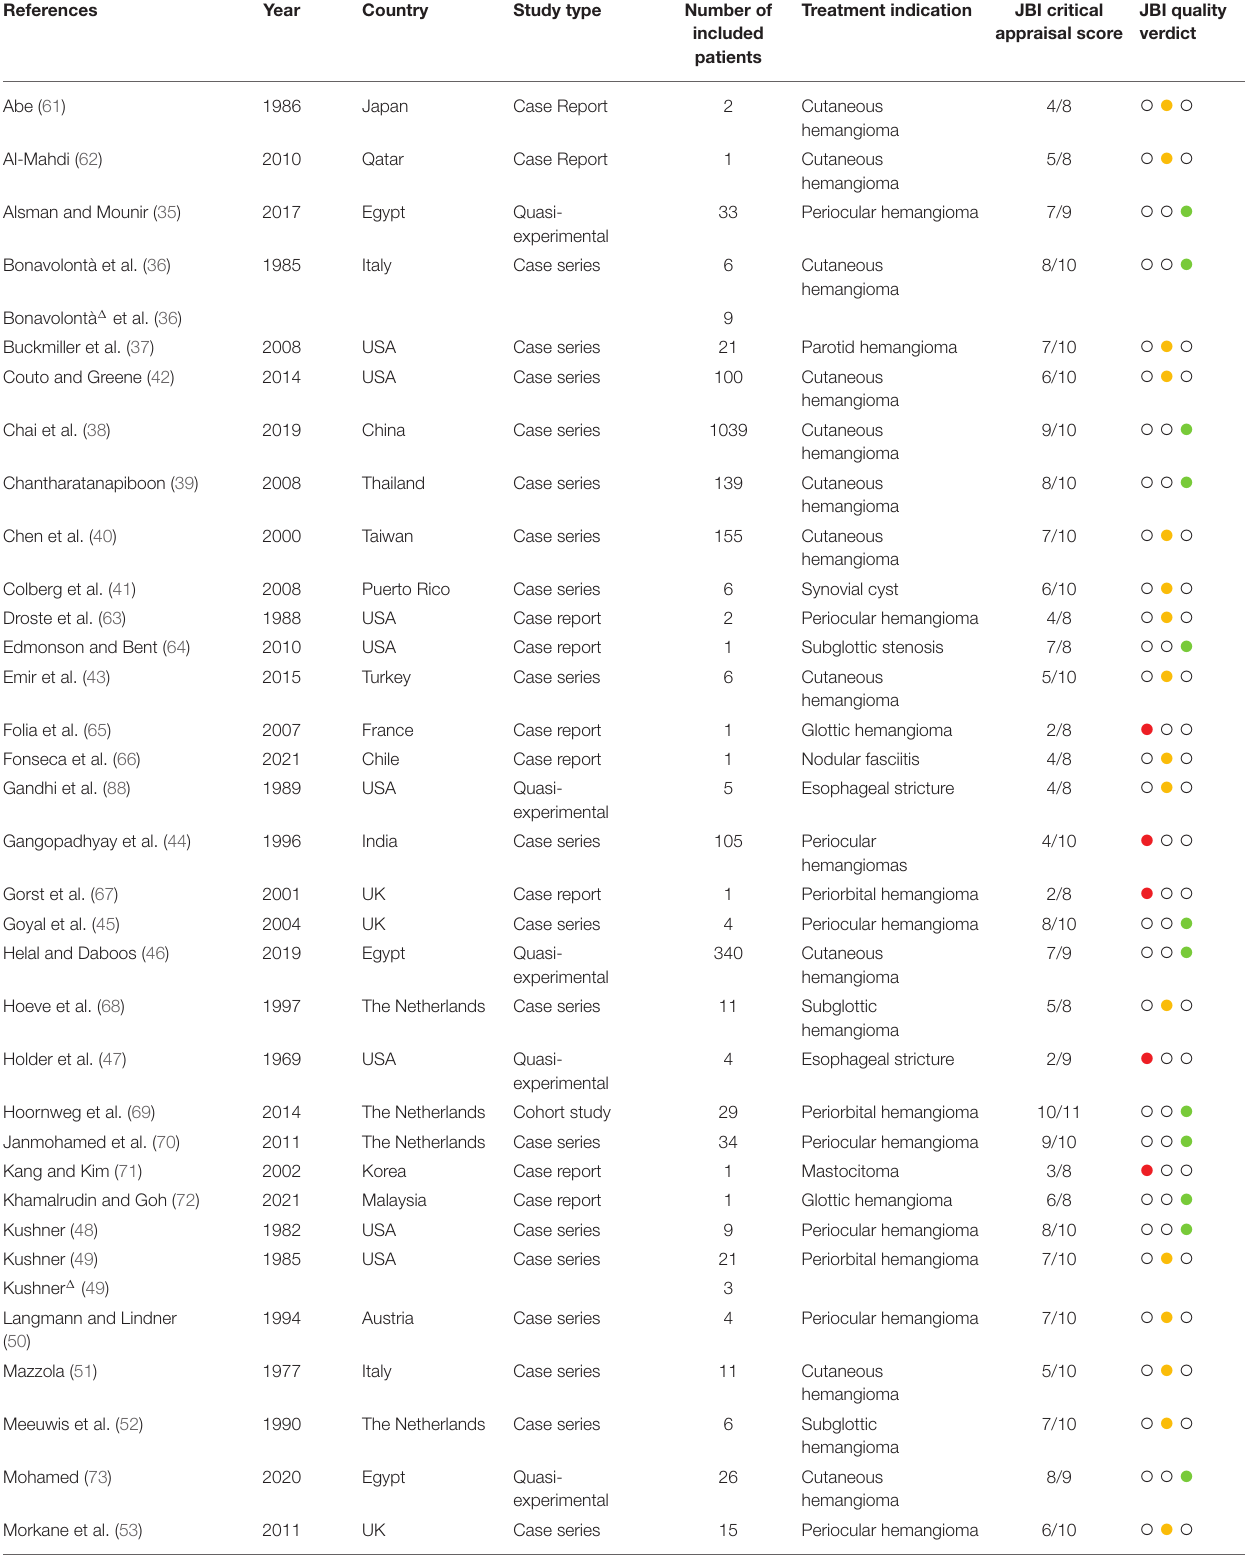
TABLE 1 | Characteristics of included